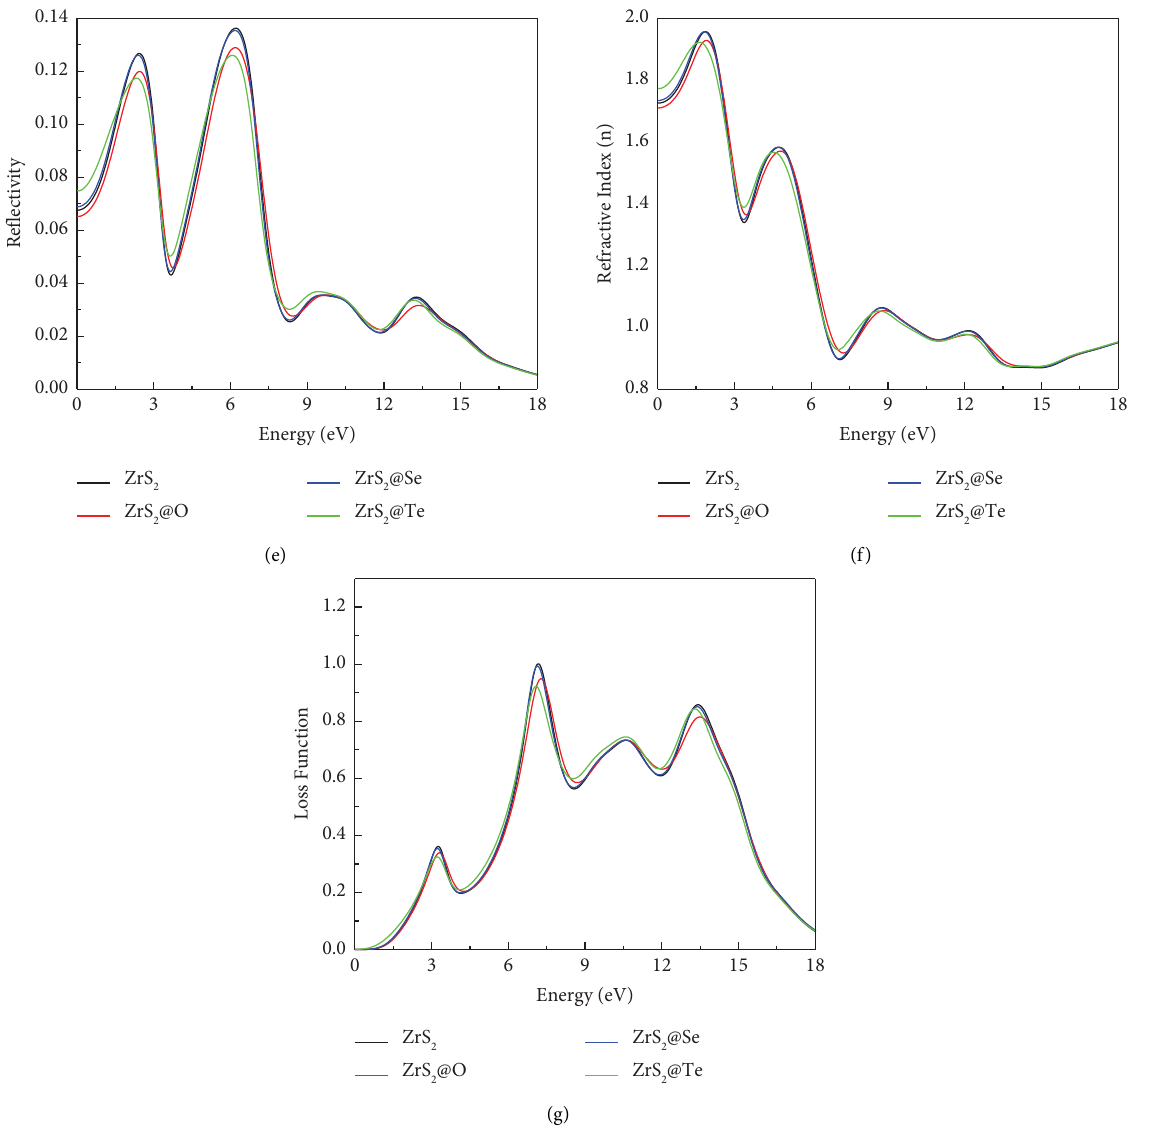
Figure 4: Diagrams of the optical parameters (absorption (a), dielectric function (real) (b), dielectric function (imaginary) (c), conductivity (d), refectivity (e), refractive index (f), and loss function (g)) of pristine ZrS 2 and X (X � O, Se, and Te)-doped ZrS 2